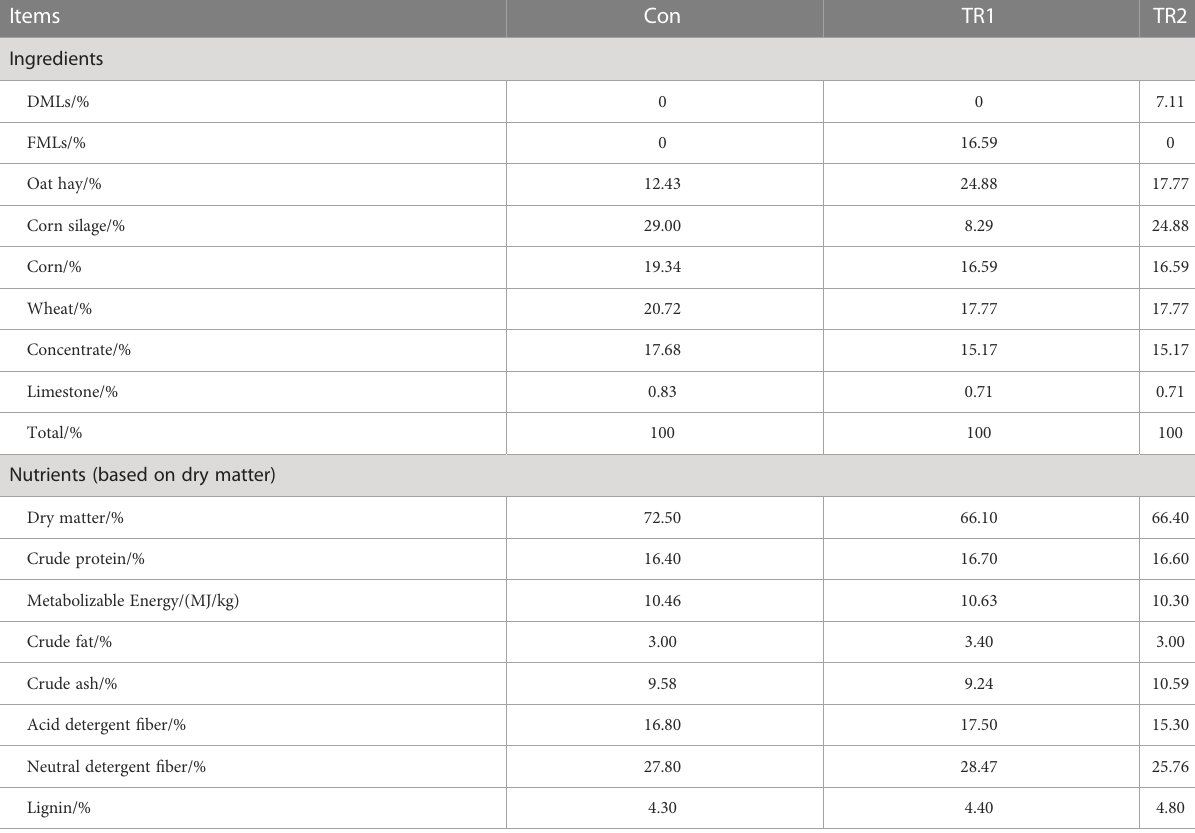
TABLE 2 Ingredients and chemical composition of three experimental